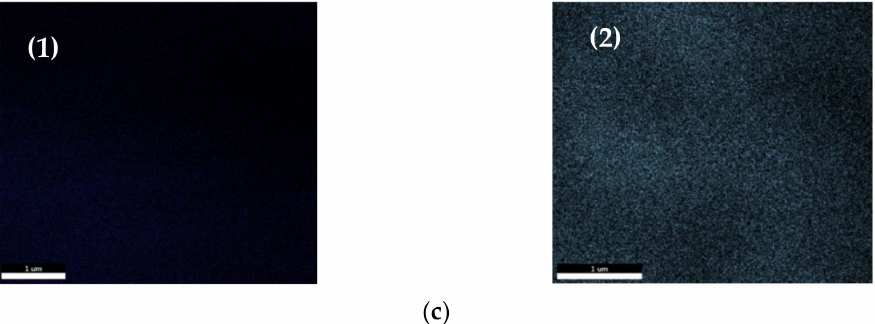
Figure 1. ( a ) FTIR spectra, ( b ) SEM images and ( c ) mapping images of Fe 3 O 4 -MPs (1) and Alg-Fe 3 O 4 - MPs